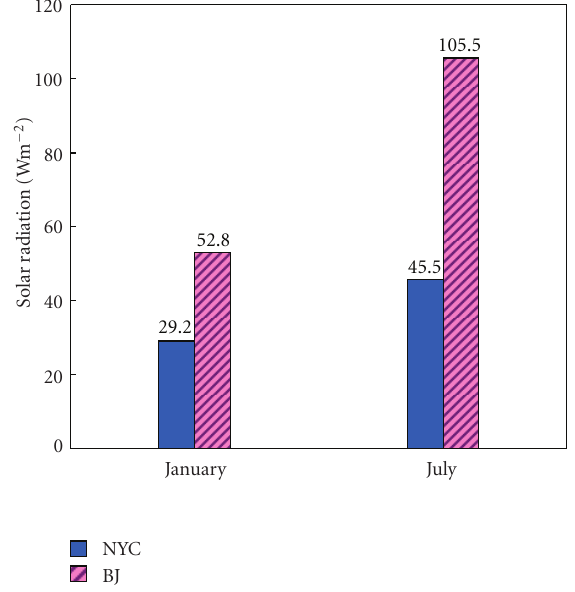
Figure 5: Aerosol reduction on surface insolation calculated from the radiative transfer model for Beijing and New York City in January and July, respectively.